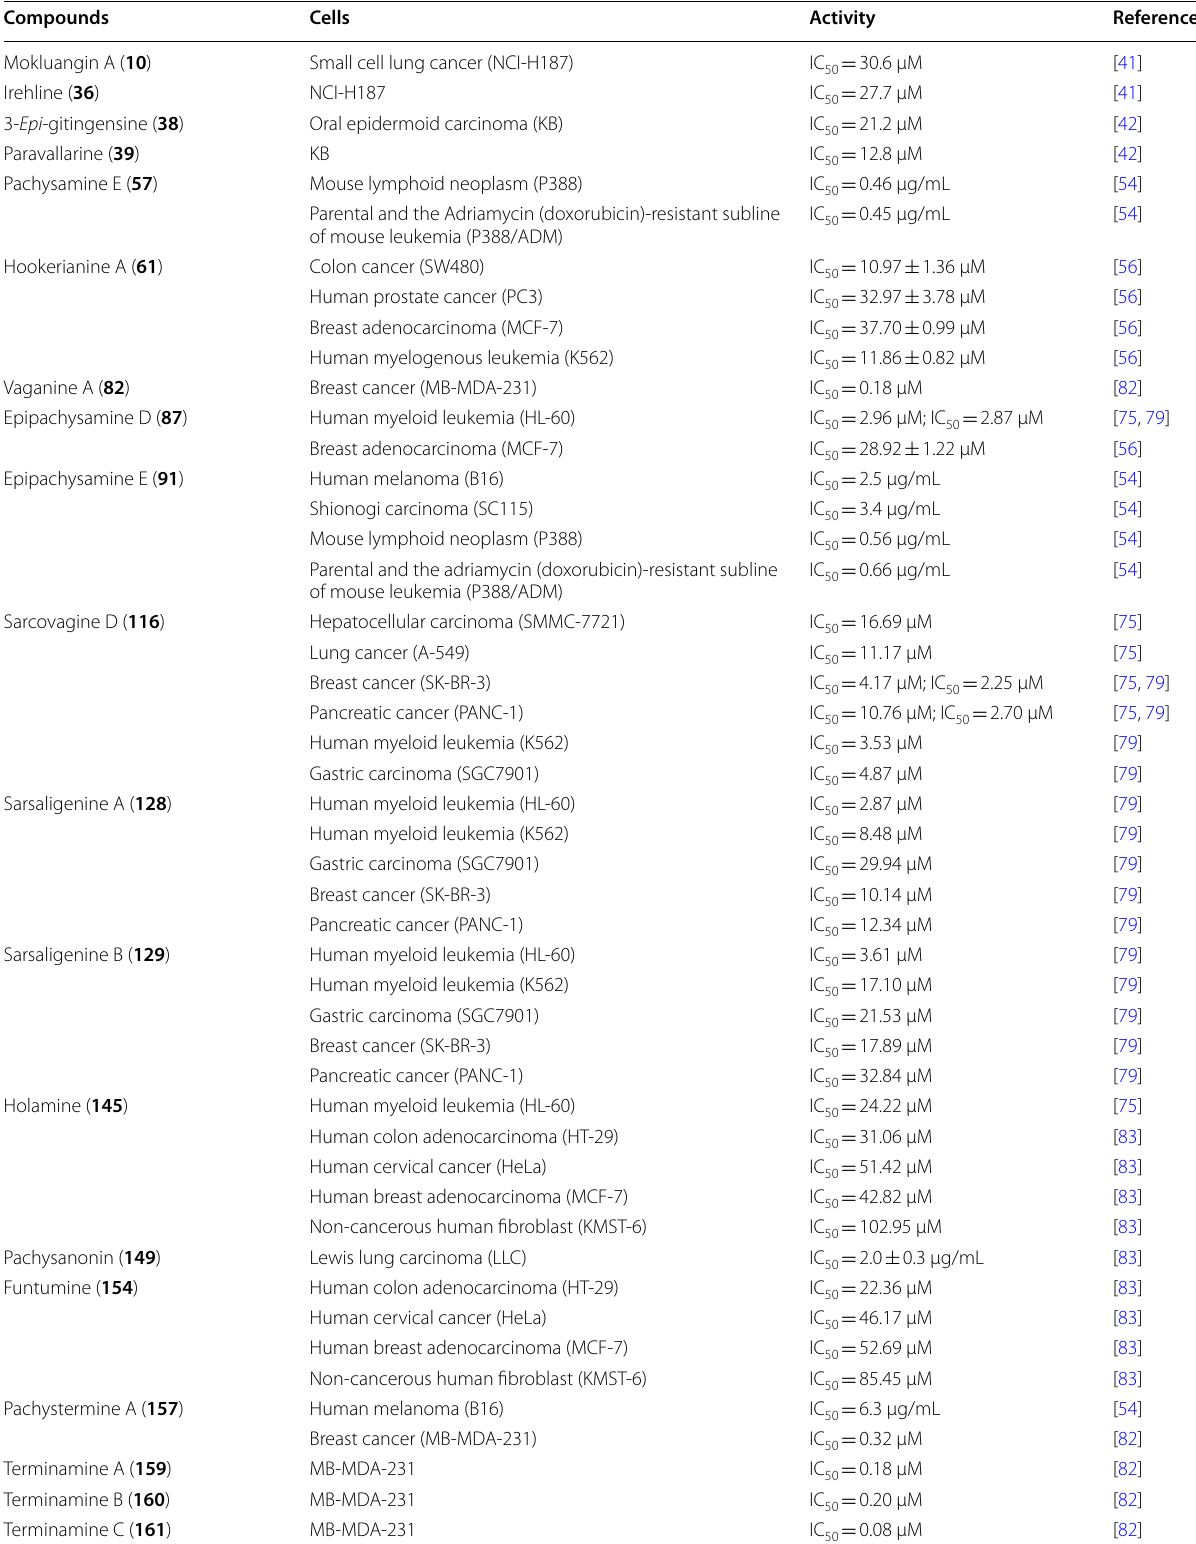
Table 18 Cytotoxic activity of steroidal alkaloids against tumor cell lines Compounds Cells